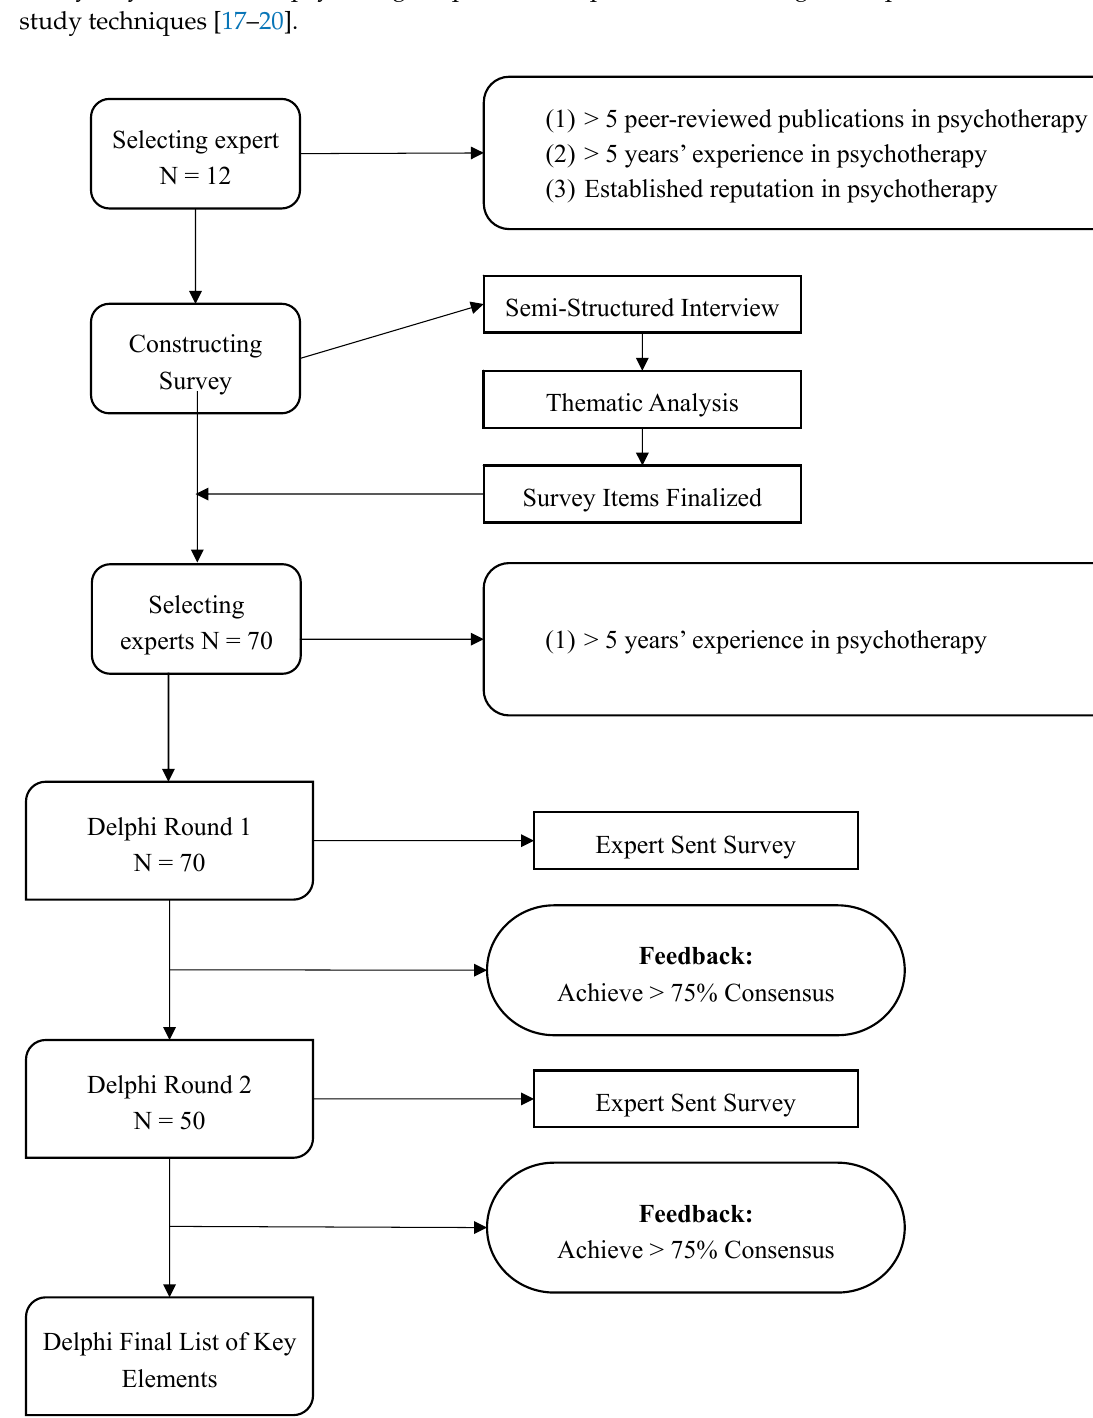
Figure 1. Delphi diagram of study process. This figure illustrates the steps taken in the current study.